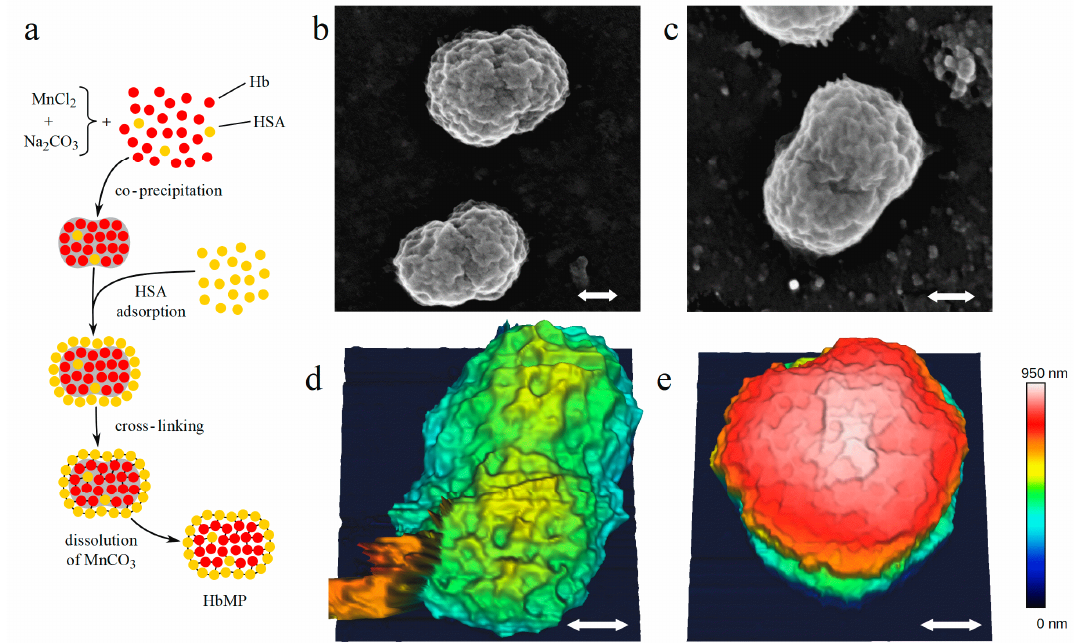
Figure 1. ( a ) Production scheme of HbMPs by co-precipitation and cross linking. ( b , c ) Images of HbMPs taken by scanning electron microscopy. ( d , e ) Atomic force microscopy of HbMPs attached with two different orientations to the surface. The white arrows correspond to a length of 200 nm in each